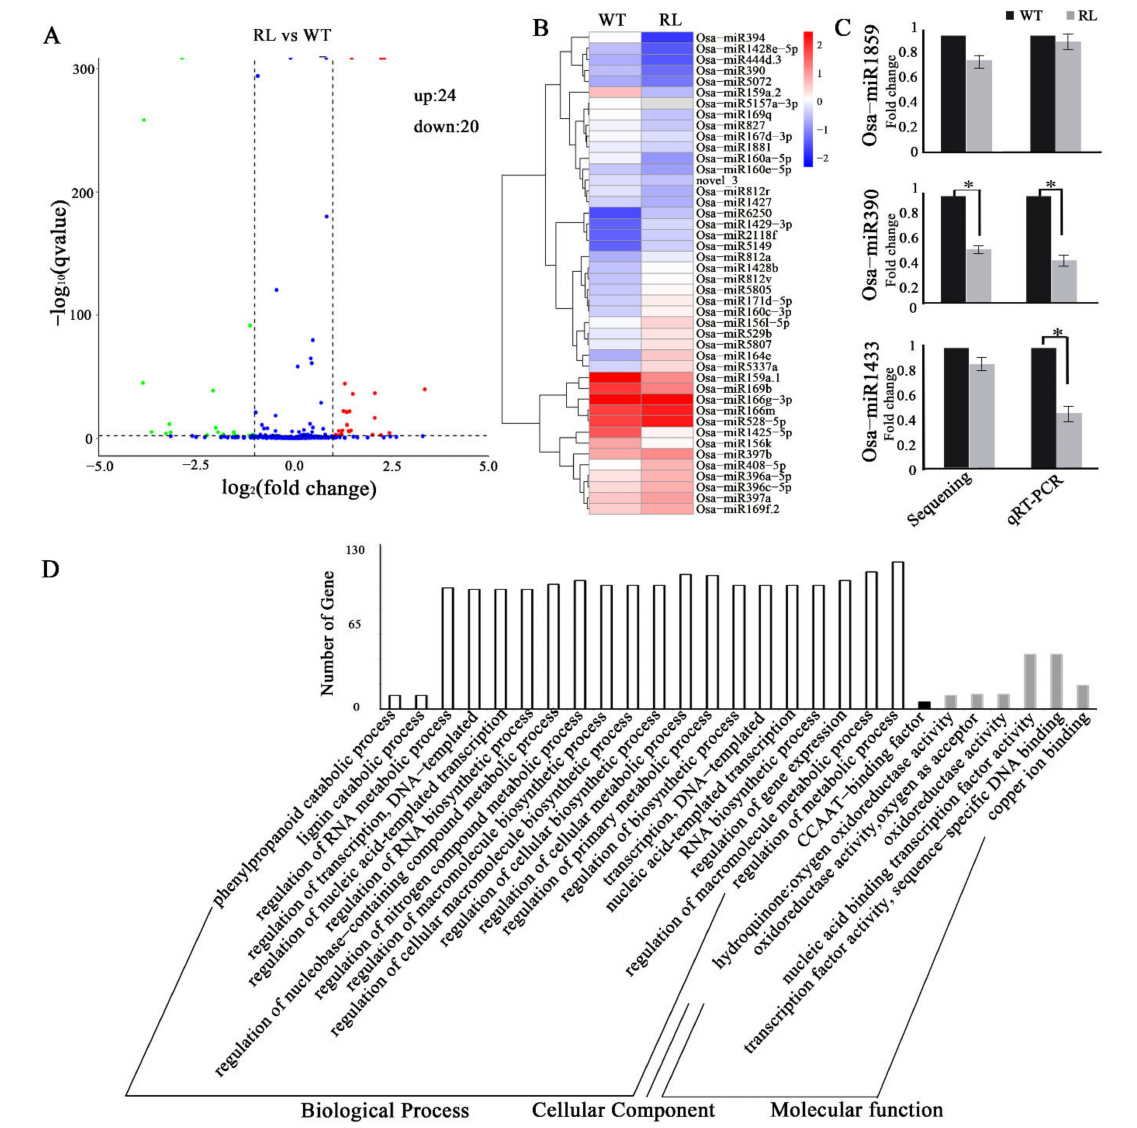
Figure 4. Differential expression of miRNAs between RL and its donor WT based on small RNA sequencing. ( A ) 44 miRNAs showed differential expression in RL vs. WT. The red dots represent up-regulated and green dots down-regulated. ( B ) Expression profiles of differentially expressed miRNA in WT and RL. ( C ) Nest-qRT-PCR verified variation of miRNA accumulation in WT and RL. * p < 0.05. ( D ) GO classification and enrichment analysis of putative target genes of the 44 differentially expressed miRNAs in WT and